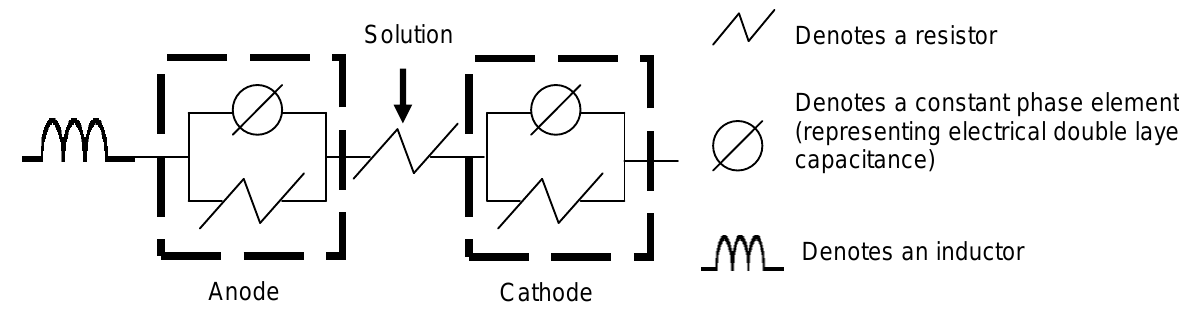
Figure 2. Equivalent circuit model representing the MFC.